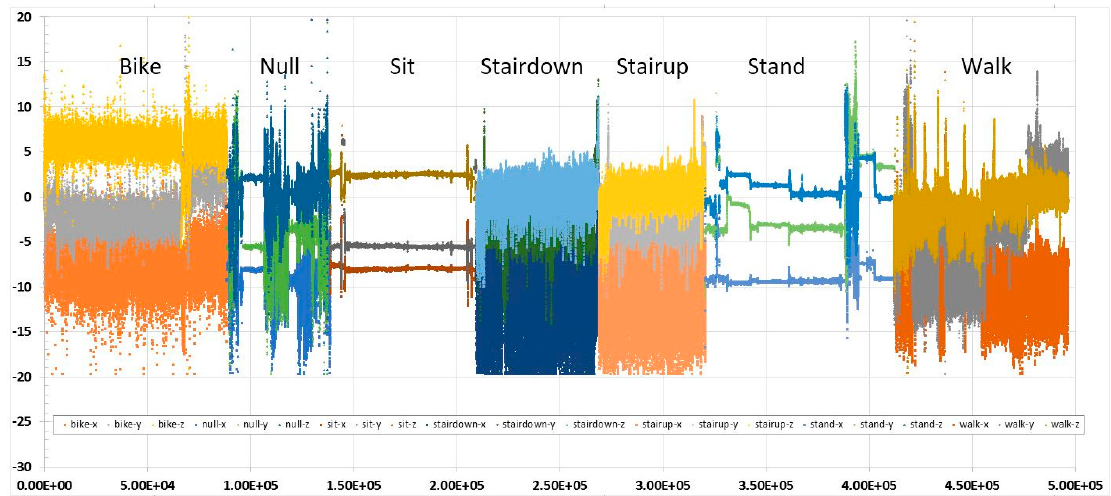
Figure 6. Visualisation of the time series of human activity data by an accelerometer.